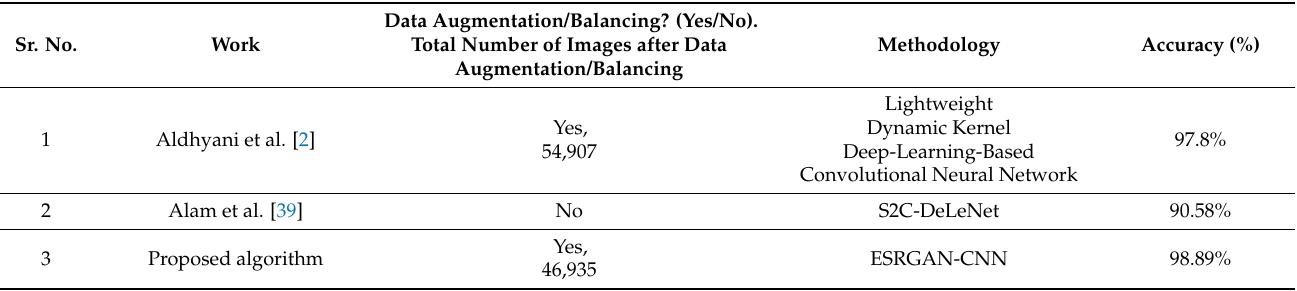
Table 12. Highest accuracy for